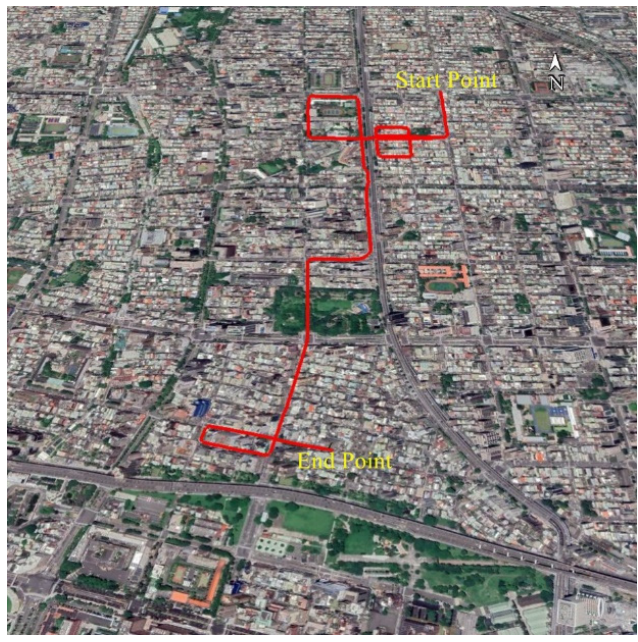
Figure 5. Vehicle trajectory in field test.